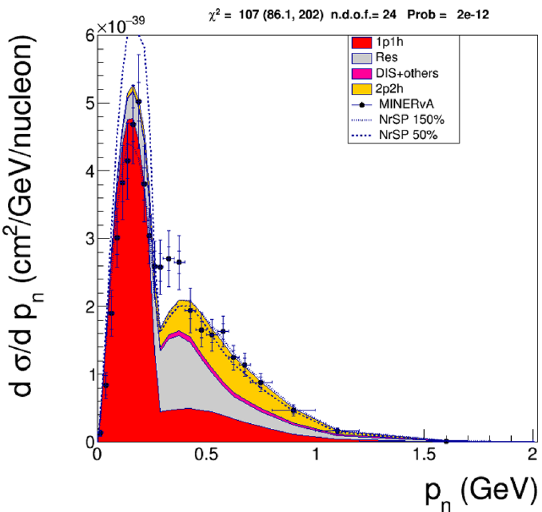
Figure 14 . MINERvA CC0 π 1p differential cross sections in reconstructed | ~p n | . Data from refs. [15, 19, 20]. We also show results from the current implementation of NEUT, with details of the comparison as in figure 8.